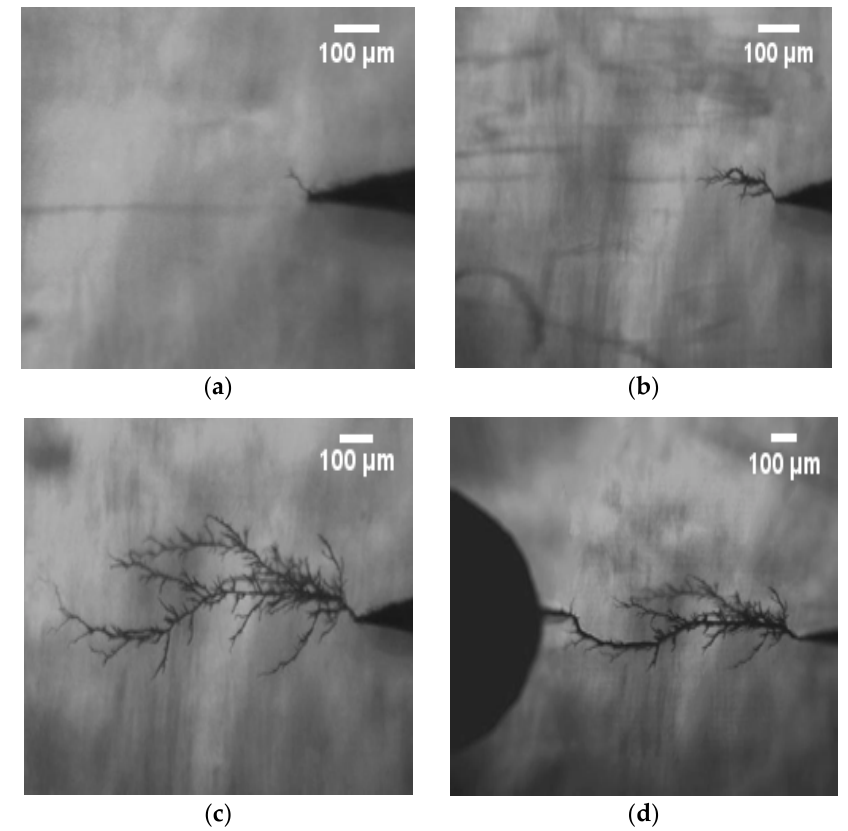
Figure 6. ET: ( a ) initiation; ( b ) development; ( c ) propagation; and ( d ) breakdown at polarity reversal of 28 kV.